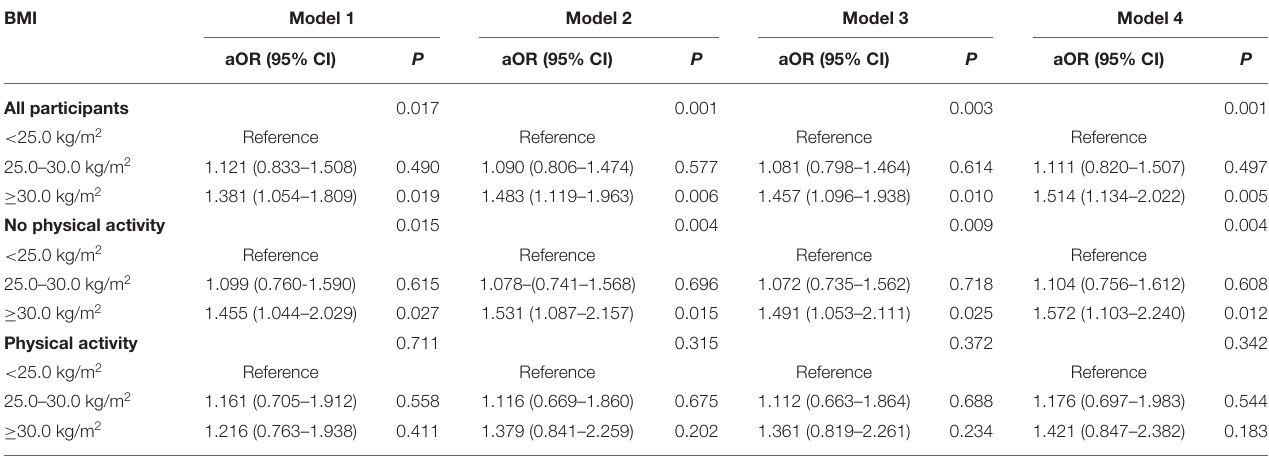
TABLE 3 | Logistic regression analyzed the relationship between BMI and the presence of kidney stone in different physical activity groups.